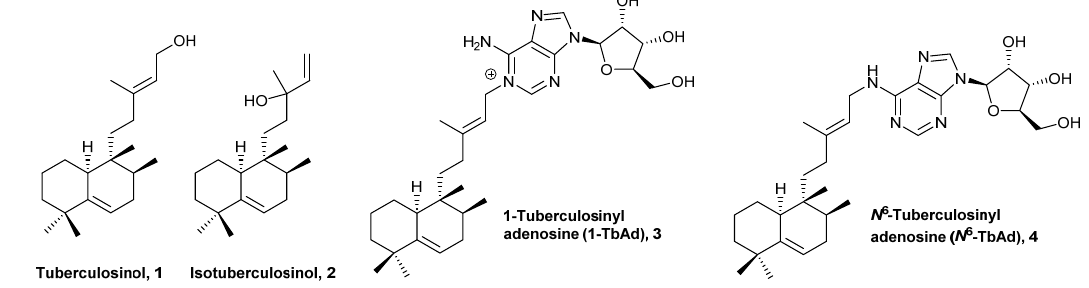
Figure 1. Tuberculosinols and derivatives.